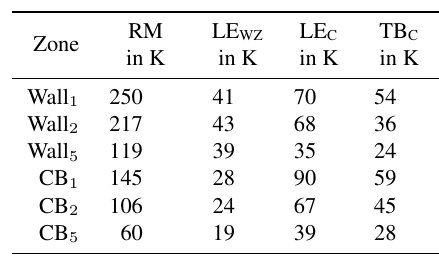
(c) Average temperature of zones based on Linear equations using (d) Average temperature of zones based on Tree bagger cluster ( TB C ) cluster ( LE C ) estimations Figure 10. The average temperatures in selected zones during a 1min sequence. Note the different temperature scales.